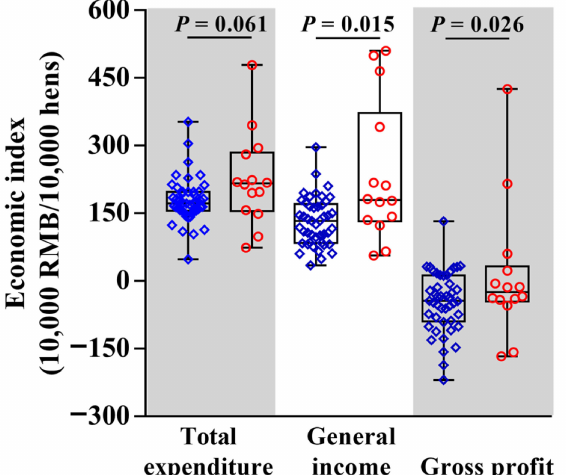
Figure 5. Total expenditure, general income and gross profit of cage and free-range laying hen farms comparison using a Nonparametric Mann–Whitney U